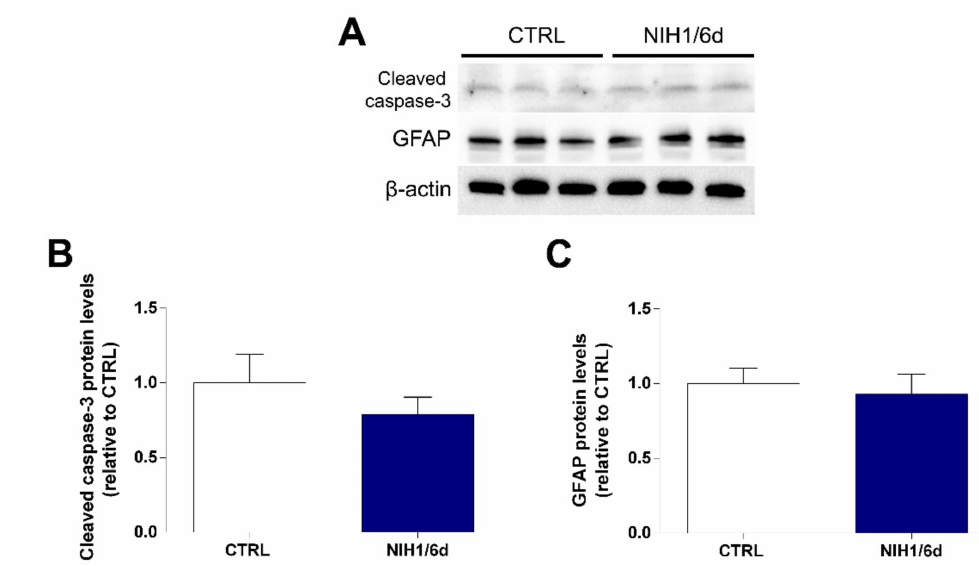
Figure 4. Effect of NIH1 on retinal cell viability and glial cell reactivity. Western blot analysis of total protein fraction showing representative immunoreactive bands ( A ) and quantitative densitometric analysis of the cleaved caspase-3 ( B ) and GFAP ( C ) protein levels in CTRL explants and in retinal explants treated with 50 µ M NIH1 for six days. Unpaired t -test, n =